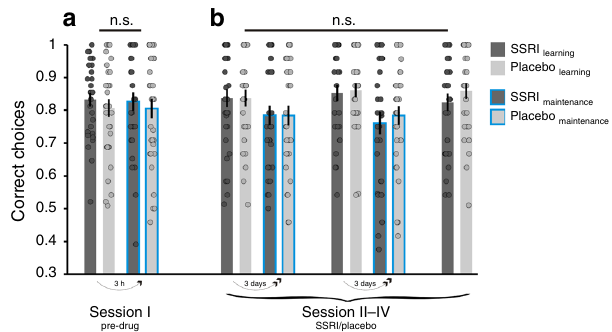
Fig. 2 No drug effects on reward learning and maintenance of learned associations. Correct choices for images learned during a the pre-drug session and b over the course of 1-week drug treatment. Task performance was quanti fi ed as proportion of choices of the image associated with a high reward probability on trials comparing images of different reward probability, i.e., high vs. low. Learning was assessed during a test block on every session, comparing images from blocks 1 and 2, encountered during preceding learning. Maintenance was assessed during interleaved trials involving familiar images on subsequent sessions, where images learned about in session I re-appeared in session II, and images from session II in session III, etc. Notably, both learning and maintenance were assessed on choices between the same image pairs, with the time-lag between learning and maintenance test constituting the only difference. Results show that learning performance was stable across sessions, and unaffected by SSRI treatment (pre-drug